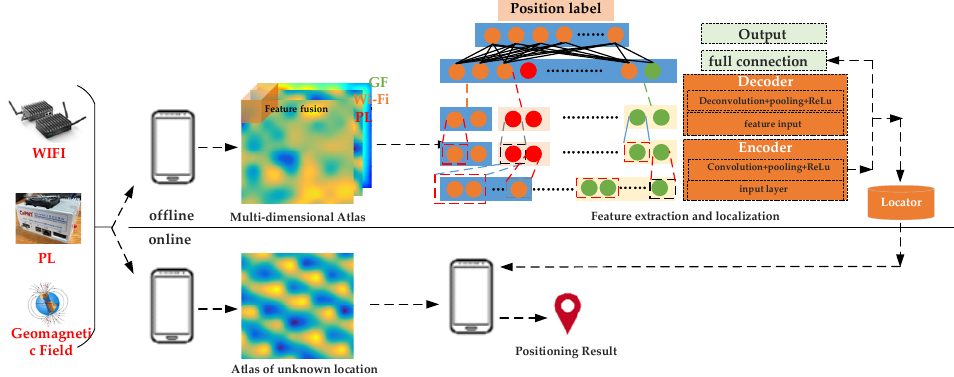
Figure 5. Schematic diagram of multi-dimensional electromagnetic atlas